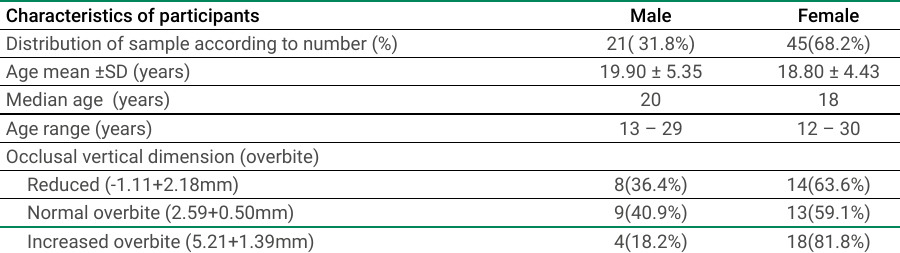
Table 1. Characteristics of participants according to